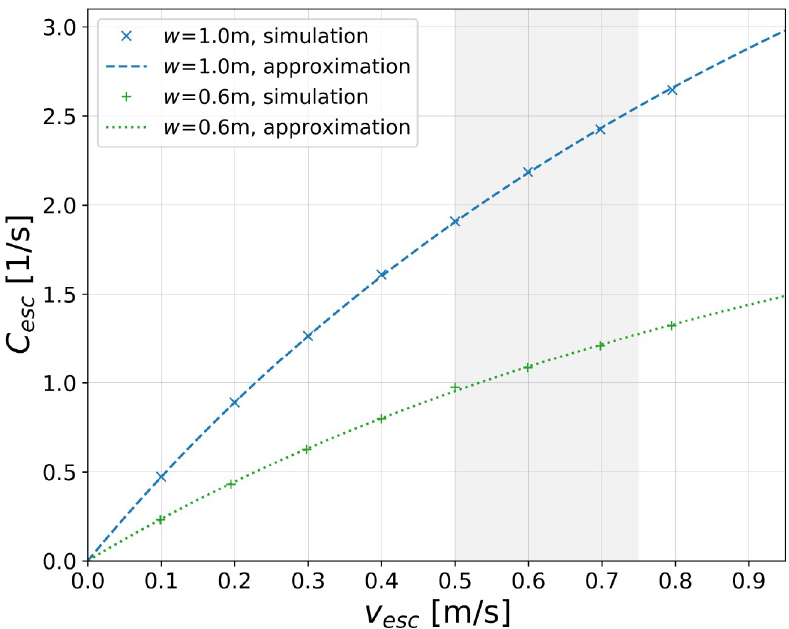
Fig 8. Non-linear speed-dependence of the escalator capacity. Shown are simulation results for the escalator widths w = 1.0 m (blue markers) and w = 0.6 m (green markers). Approximations are obtained by using Eq (16) with d step = 0.4 m and T = 0.25 s. The shaded area indicates the range of typical escalator